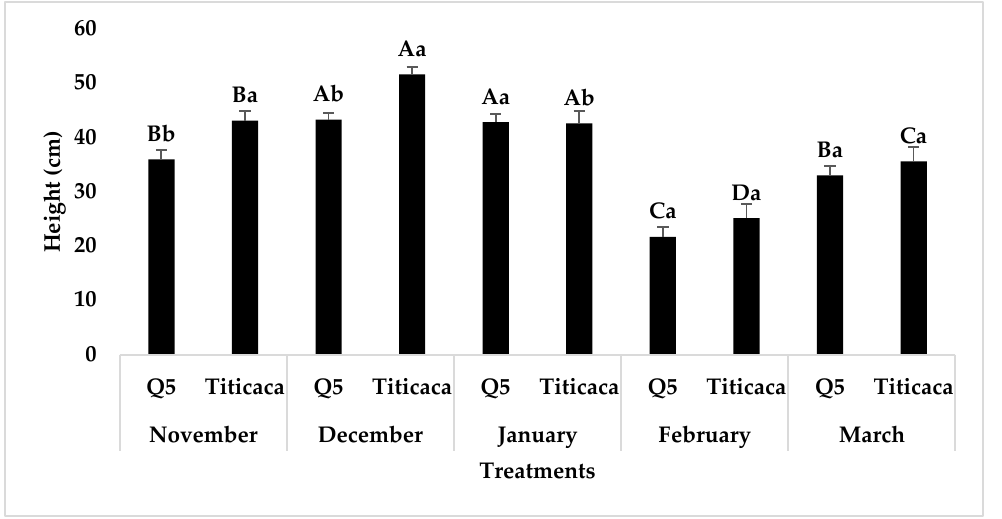
Figure 1. Final plant height of quinoa crop. For each cultivar, means followed by the same capital letters are not significantly different at p ≤ 0.05. For each sowing date, means followed by the same small letters are not significantly different at p ≤ 0.05.